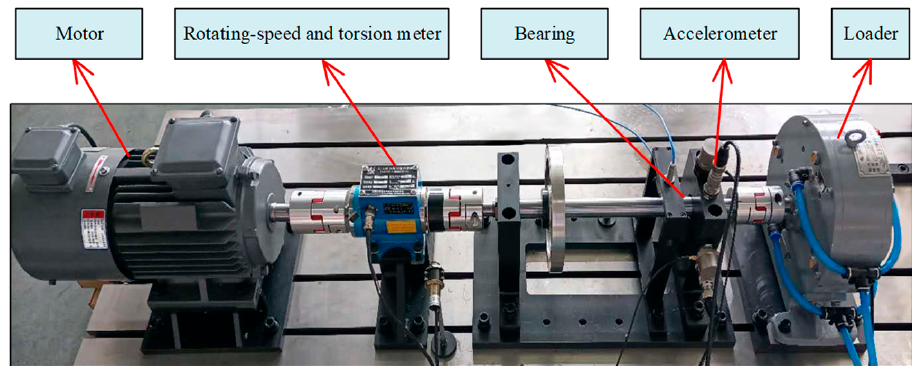
Figure 6. The bearing fault test rig used in the experiment.